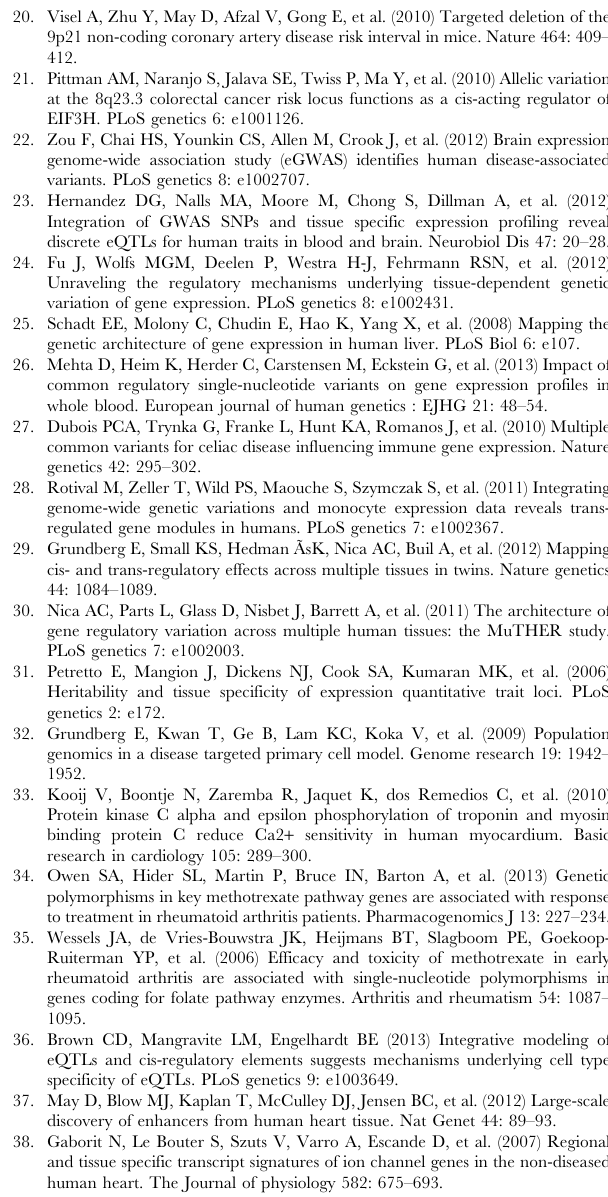
Figure S2 Results of eQTL power analyses in relation to MAF and gene expression fold change. eQTL power analyses were performed for different minimum minor allele frequencies (0.05, 0.10, 0.15, 0.20, 0.30 and 0.40). The gene expression fold change is defined as log 2 difference in gene expression observed per copy of the minor allele. In each analysis, for each log 2 fold change X , all eQTLs with an absolute log 2 fold change larger than X were considered, and the power was calculated as the percentage of those eQTLs for which the null hypothesis is rejected at FDR # 0.05. Table S1 Table of all significant eQTLs. This table contains the complete results for all significant non-diseased human heart eQTLs (FDR # 0.05). It contains for each SNP- transcript pair the SNP ID, gene or transcript IDs (HGNC, Entrez Gene, RefSeq), genomic locations, minor and major allele, minor